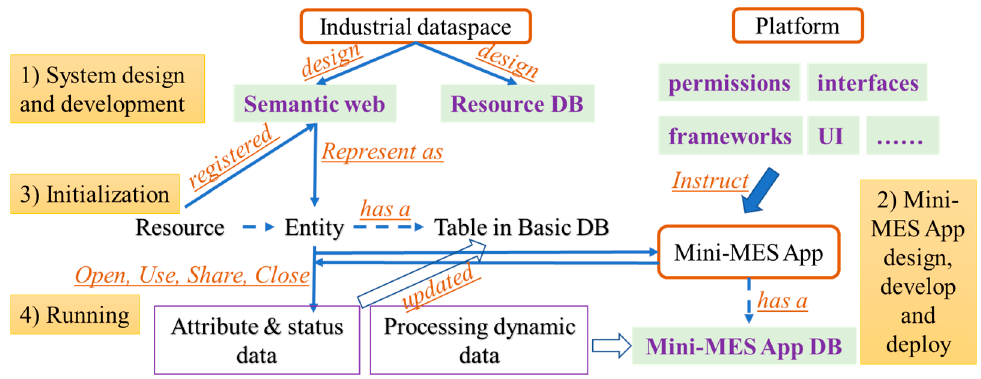
Figure 3. Running logic of the M 2 ES Apps.